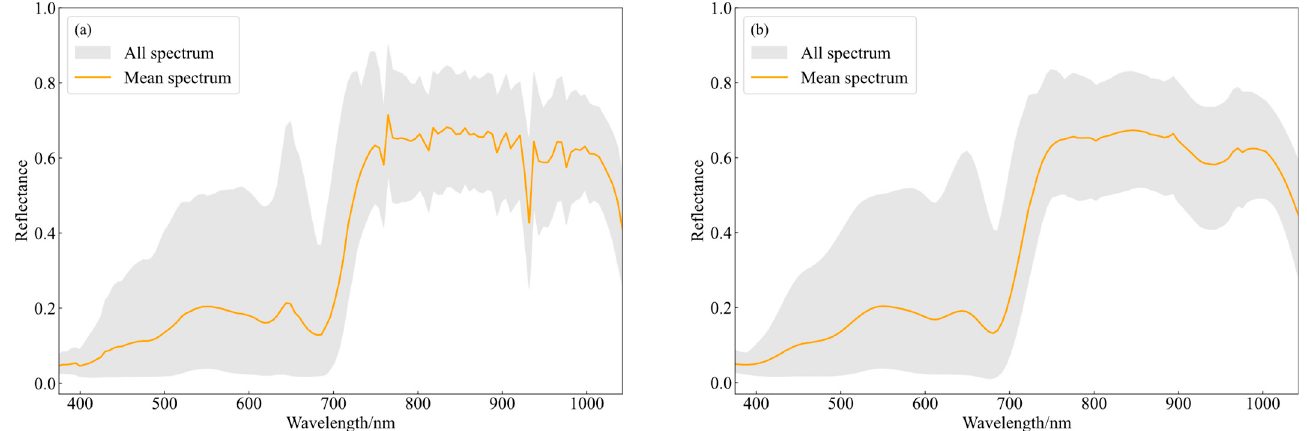
Figure 3. ( a ) Original spectral re fl ectance, and ( b ) Savi tz ky–Golay fi ltered spectral re fl ectance.